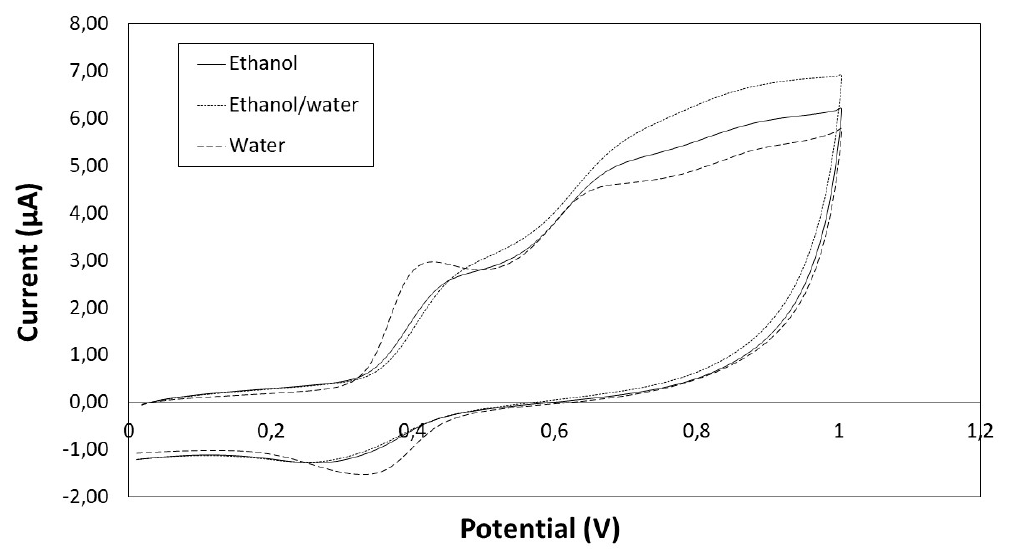
Figure4. Cyclicvoltammogramofseedsextractsobtainedwithdi ff erentsolvents(ethanol, ethanol / water Figure 4. Cyclic voltammogram of seeds extracts obtained with different solvents (ethanol, and ethanol/water and water).